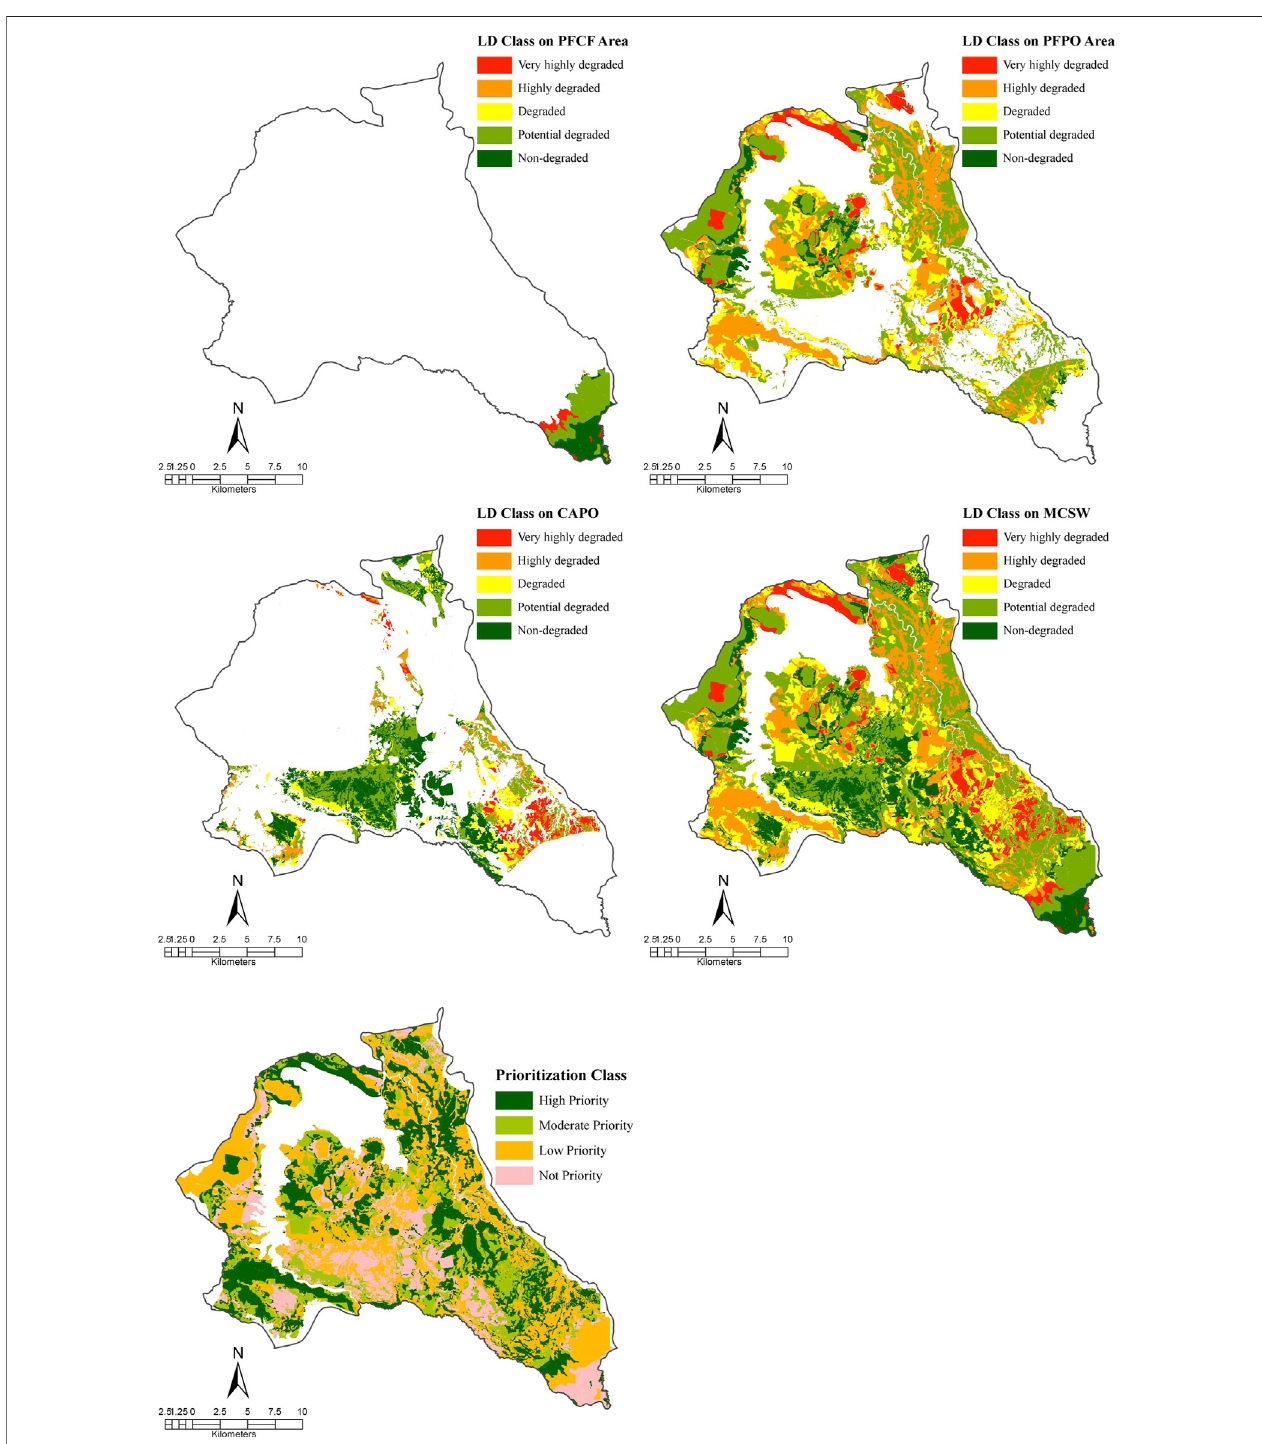
FIGURE 2 | LD class map and prioritization